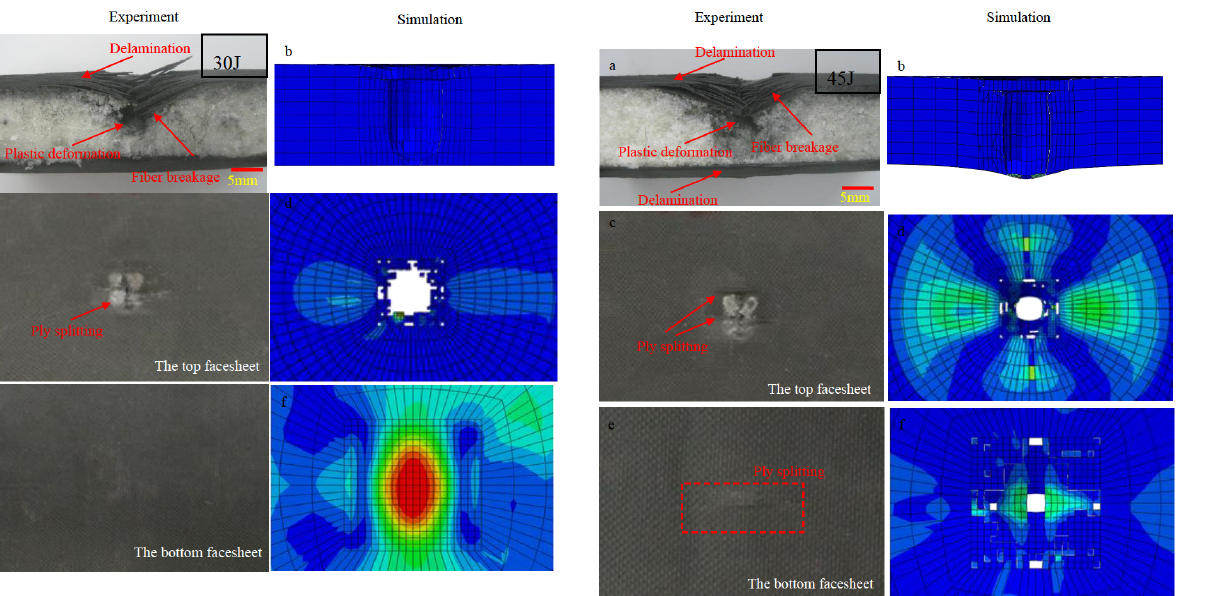
Figure 11: Impact damage of experimental and FEM simulation of foam sandwich composite at the impact energy of 30J. Figure 12: Impact damage of experimental and FEM simulation of foam sandwich composite at the impact energy of 45J.